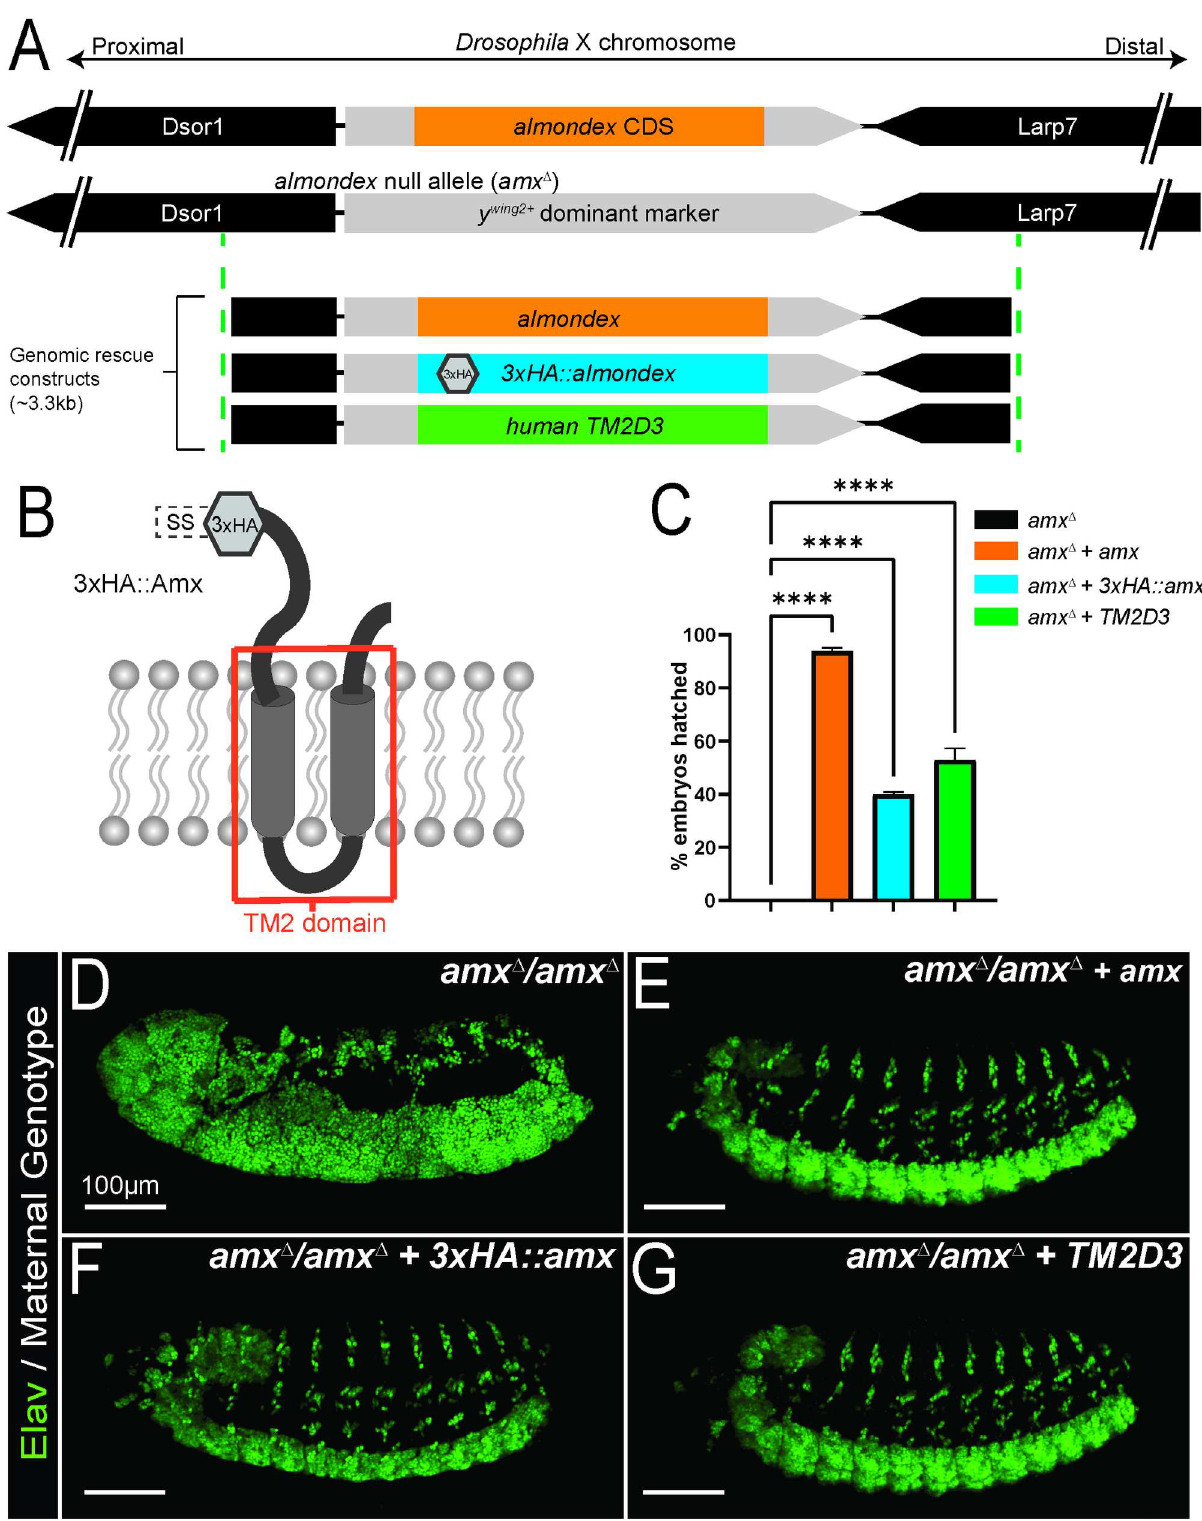
Fig 1. A clean null allele of TM2D3 fly ortholog almondex ( amx Δ ) behaves like the classic amx 1 allele. (A) Schematic diagram of almondex ( amx ) locus, amx Δ allele and genomic rescue constructs used in this study. (B) Predicted 2D-structure of Drosophila Amx protein. SS = signal sequence